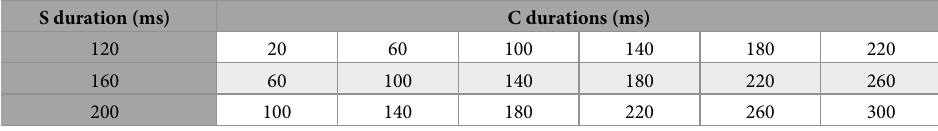
Table 1. Standard (S) and Comparison (C) durations.